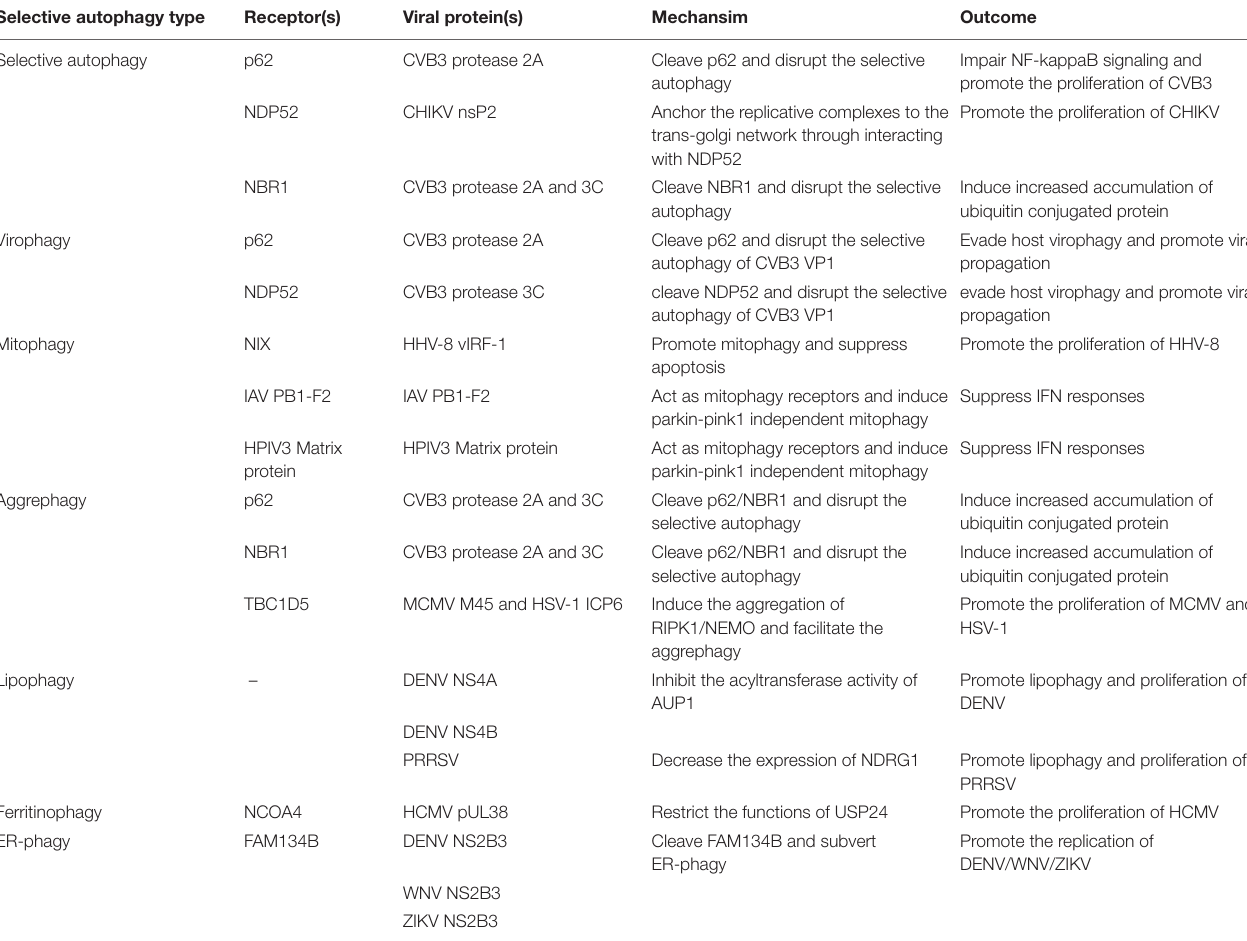
TABLE 2 | Viruses target autophagy receptors to enhance the replication of